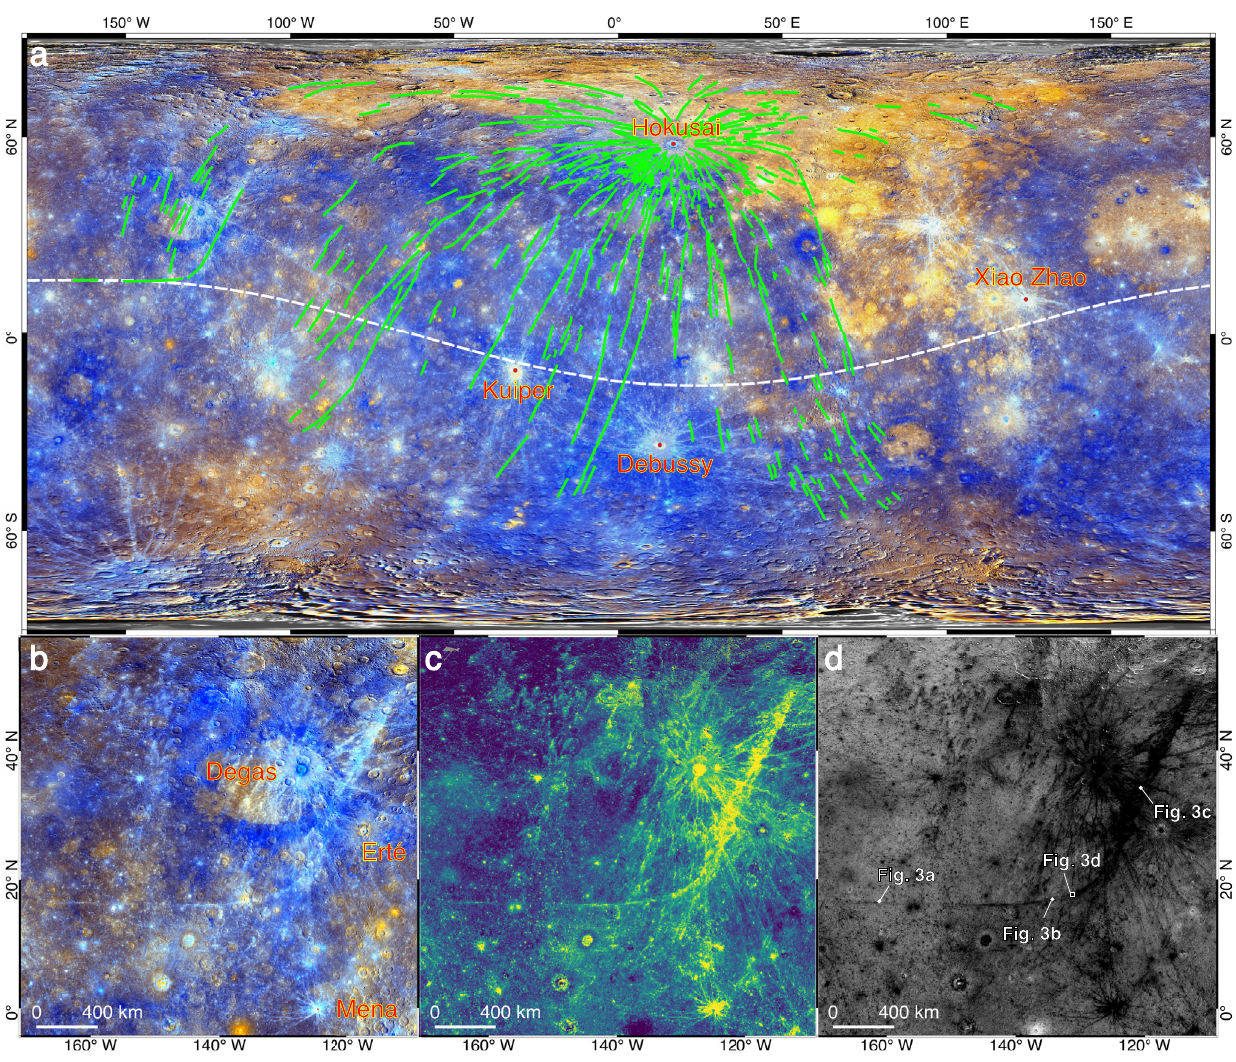
Fig. 1 | The hyperbola-shaped ray of the Hokusai crater. a Visible rays of the Hokusaicrater(rim-to-rim diameter D =114km;16.8°E,57.8°N)covermostpartsof the planet (green lines). The distribution of the rays was updated from an earlier mapping 26 (see Methods). The white dashed curve is a planet-centered great